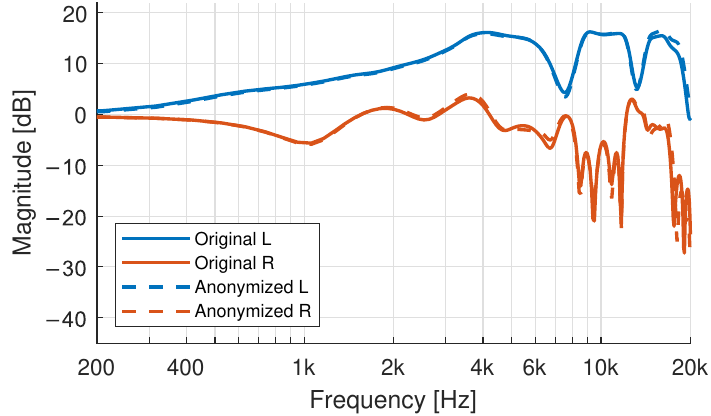
Figure 11. Comparison of simulated HRTFs of the non-anonymized (original) 3D-model and the published version with an anonymized face at 45 degrees azimuth in the horizontal